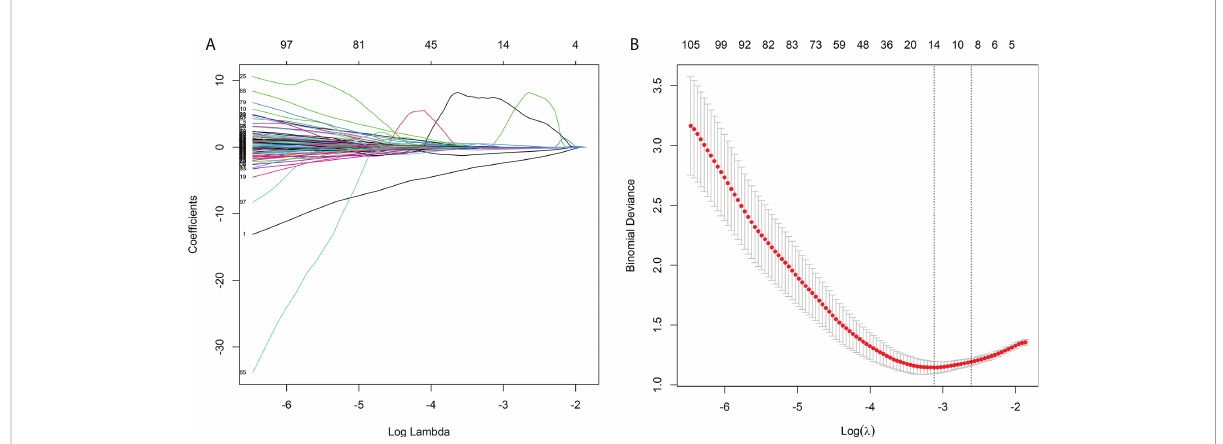
FIGURE 3 Feature selection using LASSO logistic regression and the least absolute shrinkage. (A) LASSO coef fi cient pro fi les of the features. Different color line shows the corresponding coef fi cient of each feature. (B) Tuning parameter ( l ) selection in LASSO model. The fi rst vertical line was drawn via ten-fold cross-validation based on minimum criteria.